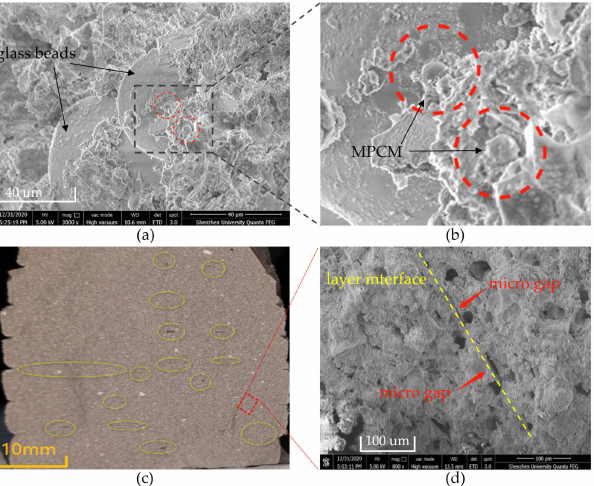
Figure 10. Printing results under microscopic and mesoscopic observations: ( a ) SEM of the GB and MPCM in the composite, ( b ) high-definition image of the MPCM particle, ( c ) visible gaps in yellow circles, and ( d ) micro